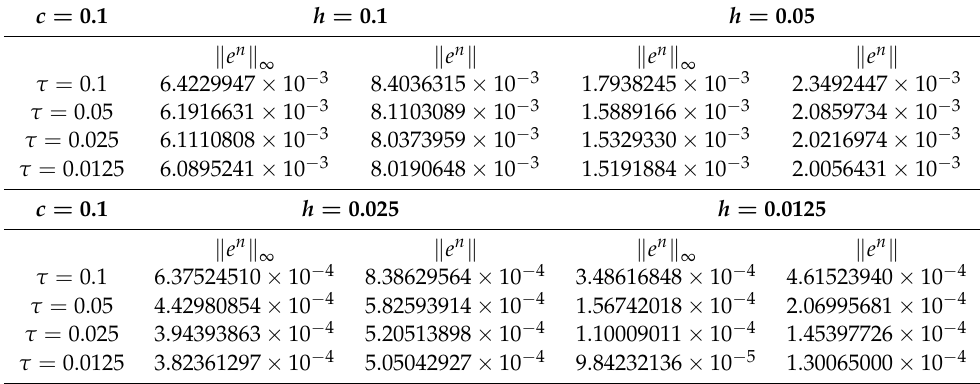
Table 2. Discrete energy E n and discrete quantities ˜ E n , Q n , and (cid:107) U n